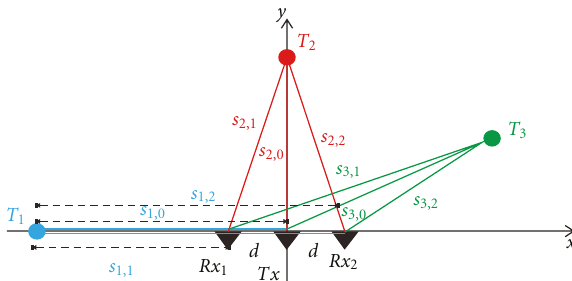
Figure 8: The scheme of the layout of the radar antennas and the targets in the monitored